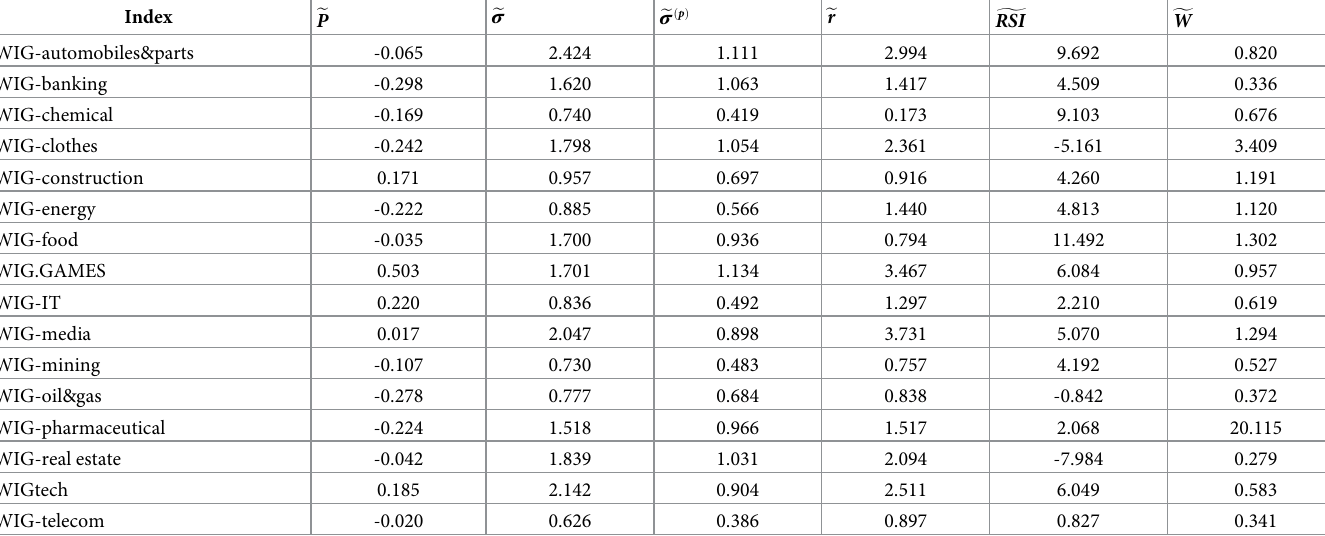
Table 2. Values of the proposed measures for evaluated sub-indices–Period_1.